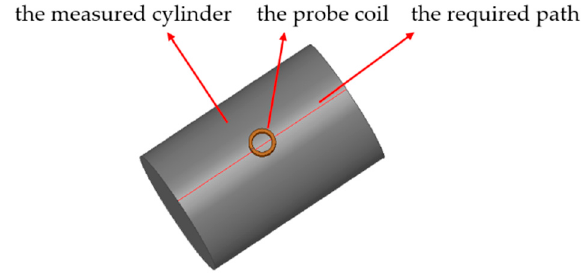
Figure 5. 3-D finite element analysis model.